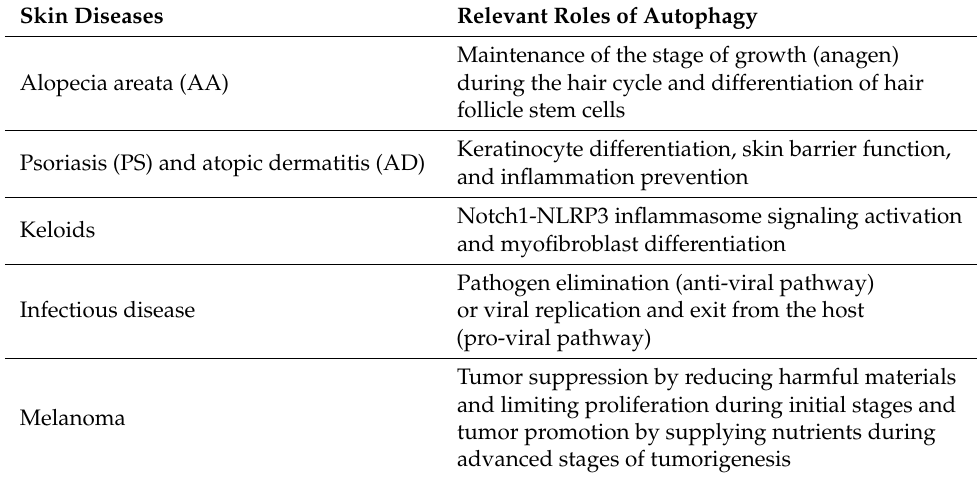
Table 1. Implication of autophagy in immune-related skin diseases. Skin Diseases